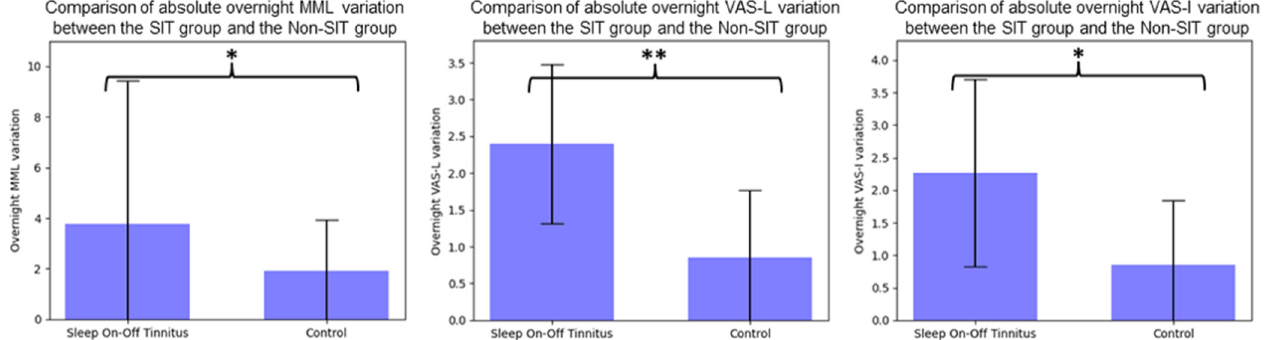
Figure 1. Comparison of absolute overnight tinnitus variation between groups, MML: Minimum Masking Level, VAS-L: Visual analog scale on tinnitus loudness, VAS-I: Visual analog scale on tinnitus intrusiveness. *: p < 0.05, **: p < 0.01